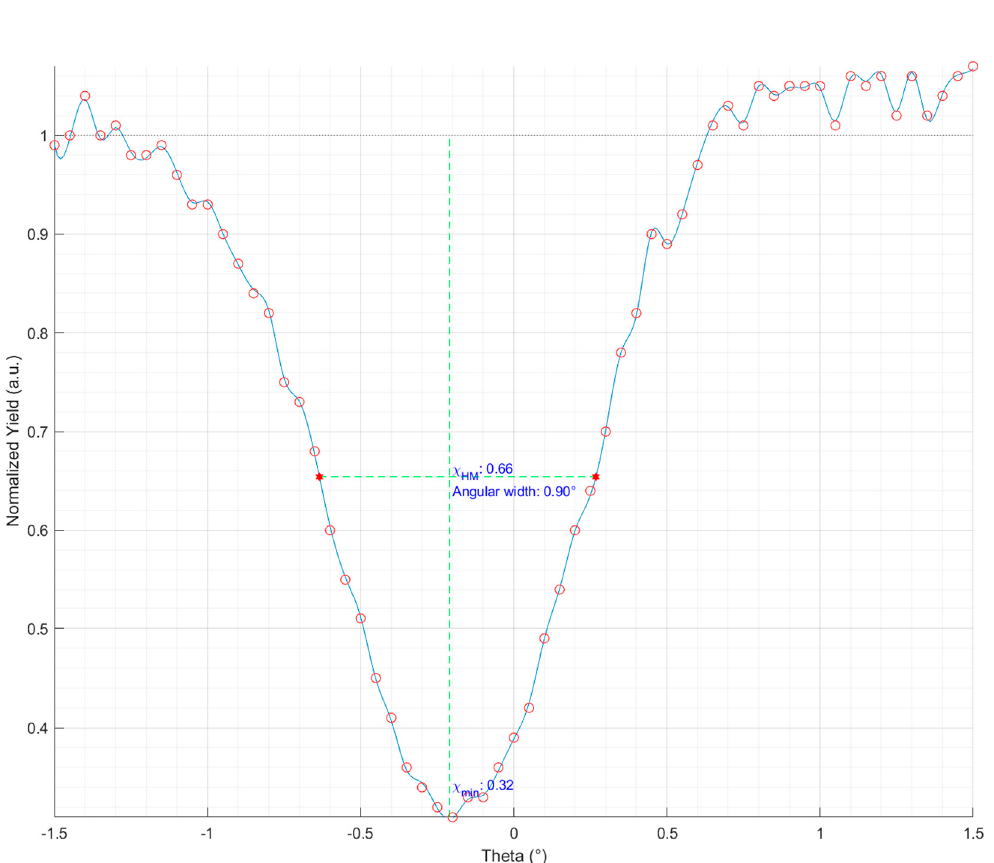
Figure 17. Normalized yield of a fine measurement with measured and calculated values. The channeling dip features a reduction in ROI counts by a factor 0.32 with a FWHM width of 0.90° .